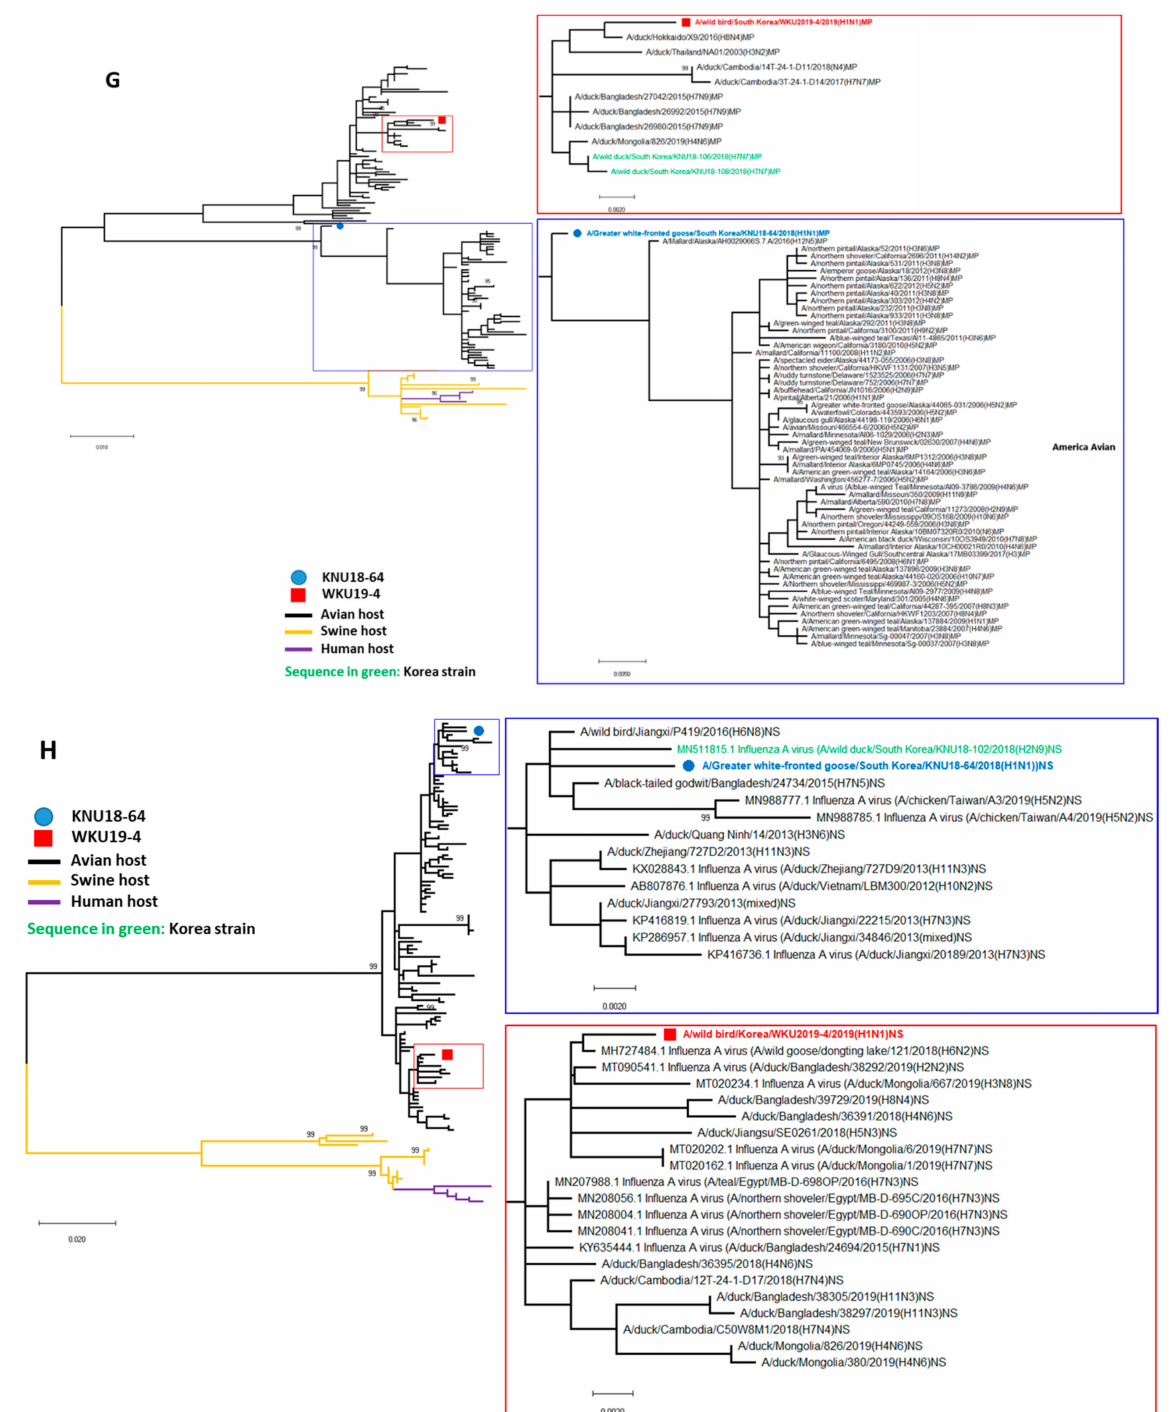
Figure 2. Phylogenetic trees based on the nucleotide sequences of HA ( A ), NA ( B ), PB2 ( C ), PB1 ( D ), NP ( E ), PA ( F ), MP ( G ), and NS ( H ). The trees were generated by the neighbor-joining method using MEGA 6.0 software with bootstrap replication (1000 bootstrap iterations). The KNU18-64 strain (A/ Greater white-fronted goose /South Korea/KNU18-64/2018(H1N1)) is indicated by blue circles and the WKU19-4 strain (A/wild bird/South Korea/WKU19-4/2019(H1N1)) is indicated by red boxes. The avian, swine, and human hosts are represented in black, orange, and purple, respectively. The Korean strains are shown in